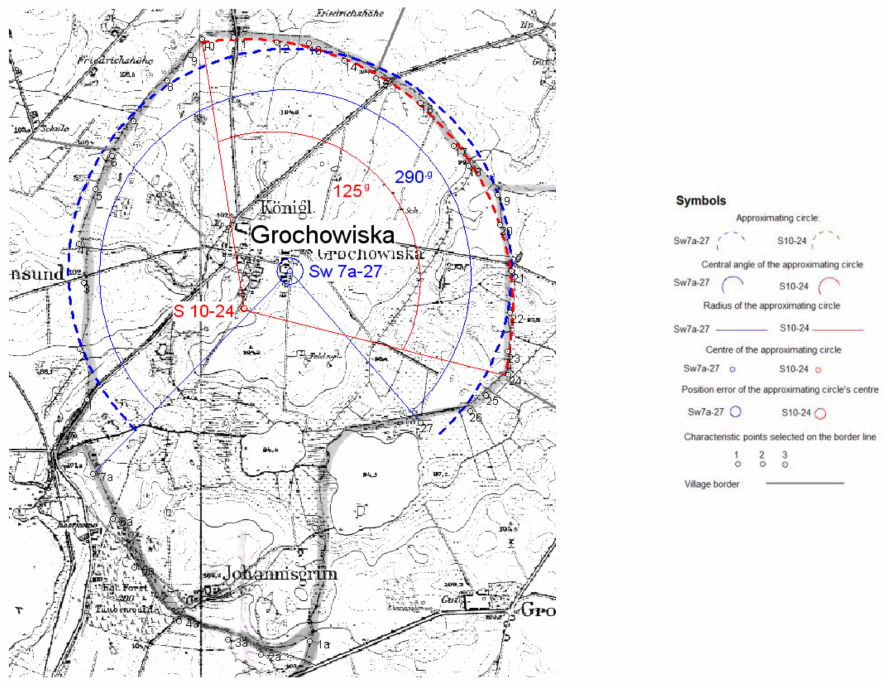
Figure 12. Grochowiska. Course, position and error of the approximating circle: Sw 7a—27—